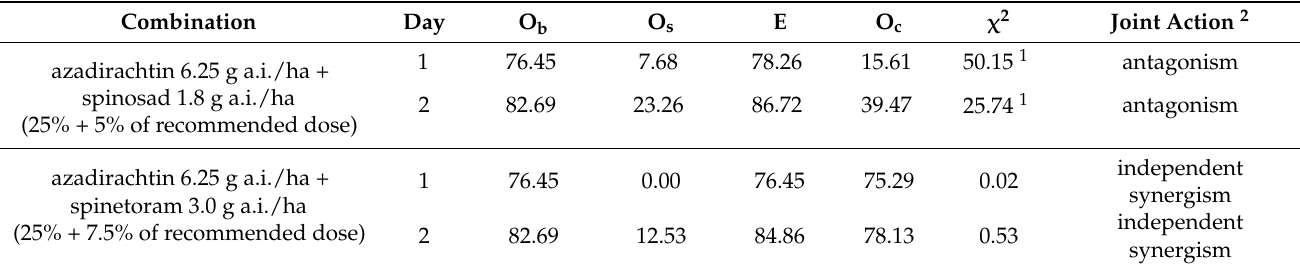
Table 7. Joint action of insecticides based on potato leaf area preservation data.